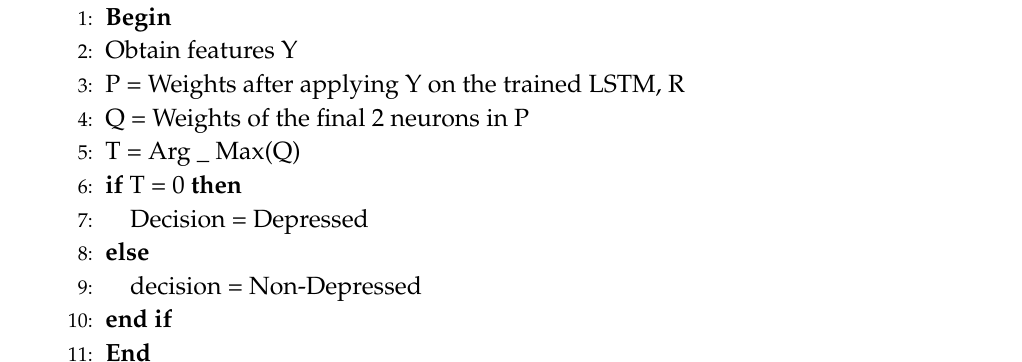
Algorithm 3 Prediction